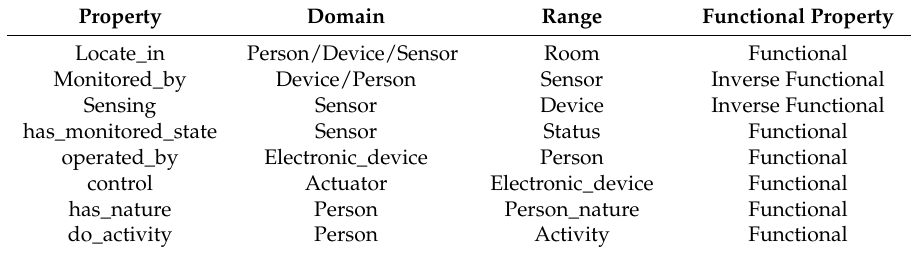
Figure 8. Ontology view focusing on service knowledge